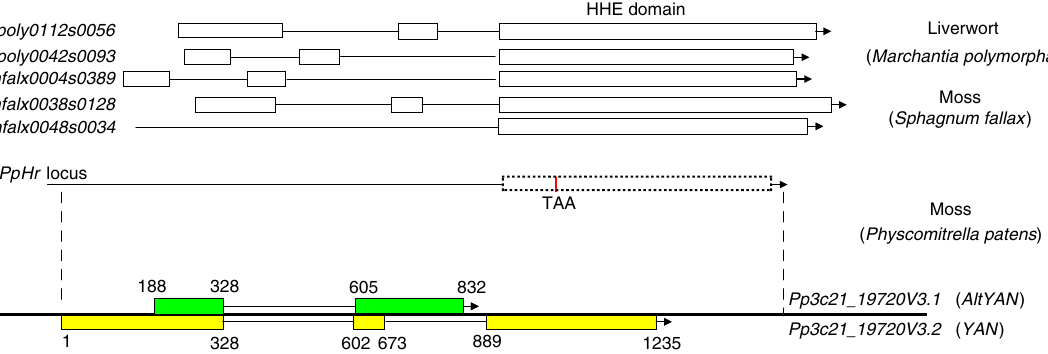
Fig. 1 Gene structure of the dual-coding gene YAN/AltYAN . Two copies of the Hr gene exist in the liverwort M. polymorpha and three copies in the fl attop bog moss S . fallax . The identi fi ers of Hr sequences from Phytozome are indicated. The Hr locus in P. patens contains no start codon ATG but a premature stop codon TAA. The dual-coding gene YAN/AltYAN evolved from the pre-existing Hr locus. The two transcripts, YAN and AltYAN , are shown in yellow and green, respectively, and their exon positions